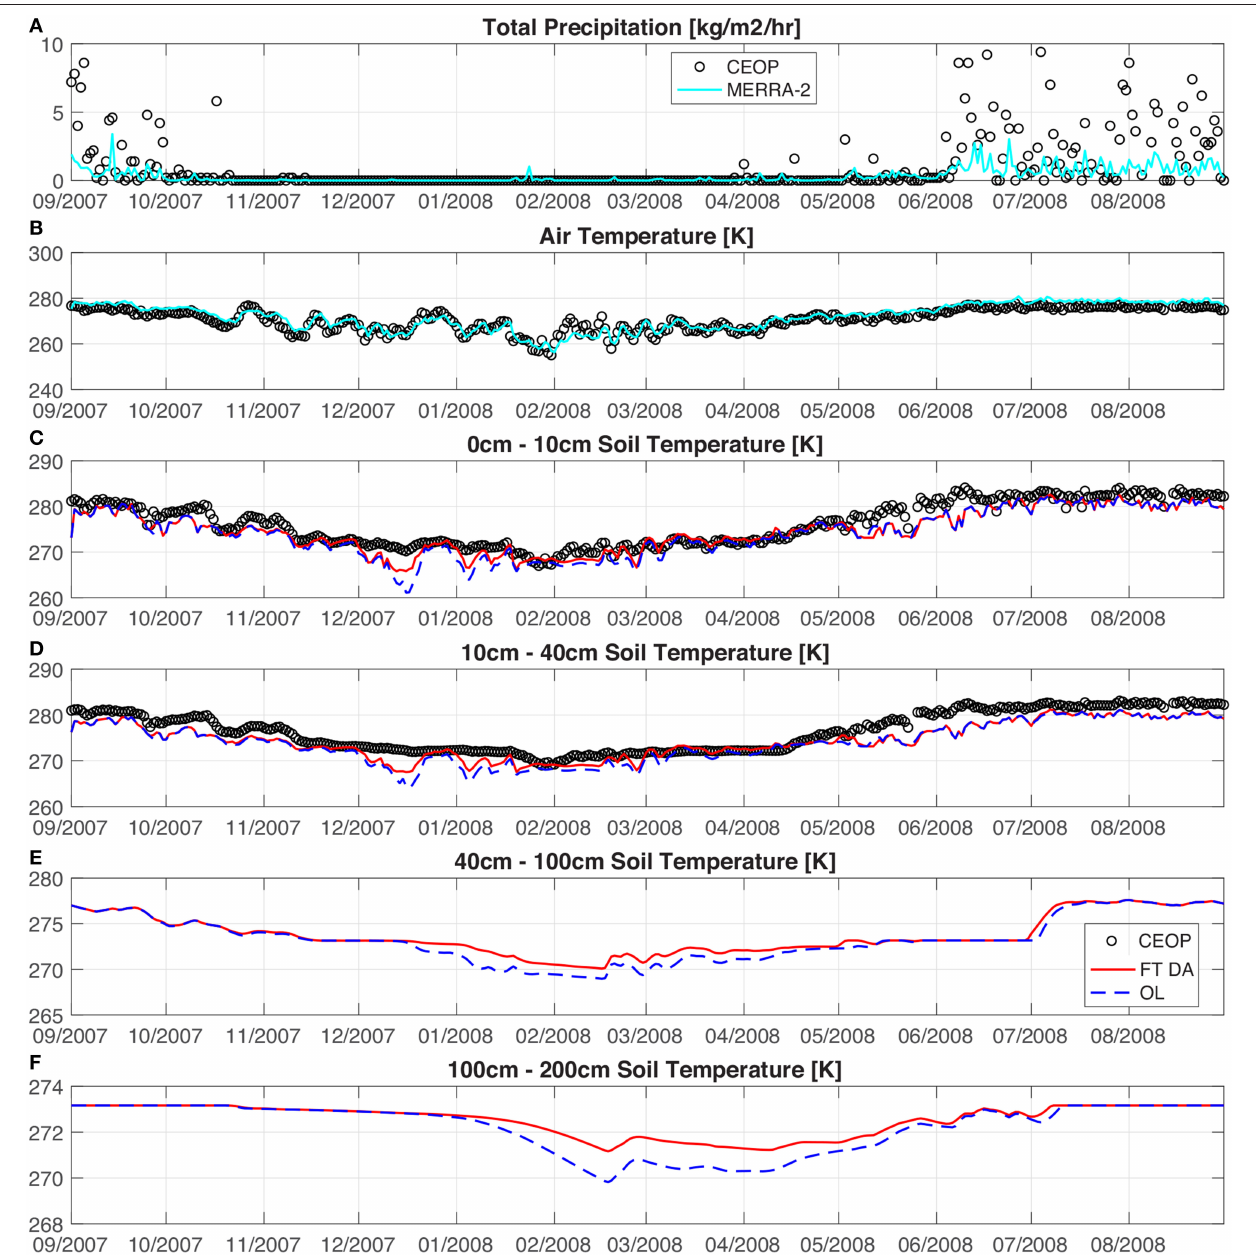
FIGURE 8 | Comparisons of daily-averaged (A) MERRA-2 total precipitation and CEOP Syangboche station measured precipitation, and (B) MERRA-2 air temperature and CEOP Syangboche station measured air temperature. Comparisons of the model simulated, including both OL and FT DA derived, daily-averaged soil temperature profiles against CEOP measurements, including (C) top-layer (0–10 cm), (D) second-layer (10–40 cm), (E) third-layer (40–100 cm), and (F) fourth layer (100–200 cm). No CEOP measurements are available at the third and fourth soil layers. The evaluation period is from 1 September 2007 to 31 August